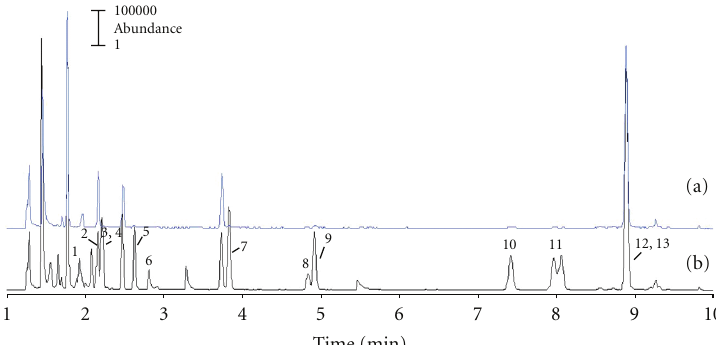
Figure 3: Total ion chromatogram obtained for a membrane filled with 50 mg of XAD-2 (a) and a membrane filled with 50mg of XAD- 2 spiked with 1500 ng of VOC standard mixture (b). Note: peaks correspond to Chloroform (1), 1,2-Dichloromethane (2), Benzene (3), Cyclohexane (4), Trichloroethylene (5), Bromodichloromethane (6), Toluene (7), Dibromochloromethane (8), Tetrachloroethylene (9), Ethylbenzene (10), m,p-Xylene (11), Bromoform (12), and o-Xylene (13).